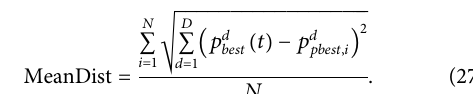
FIGURE 4 45 Node distribution network structure diagram.